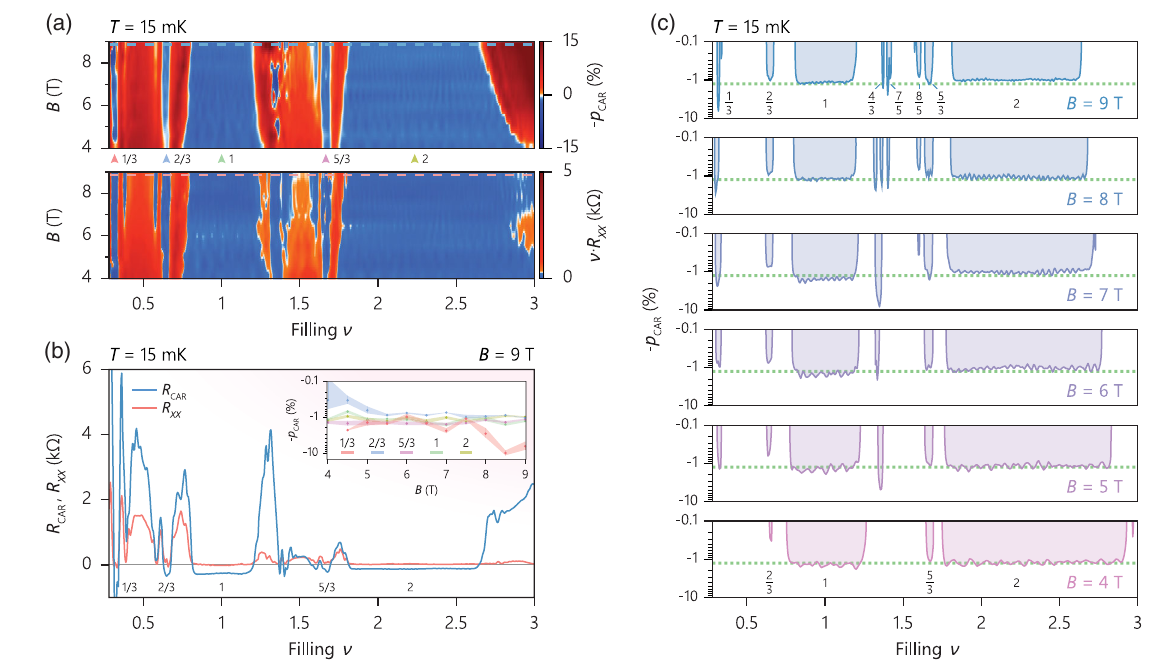
FIG. 3. Magnetic field dependence. (a) p and R (normalized for different ν ) as a function of filling and magnetic field B . These XX CAR measurements have a step size of 0.5 Tand have been interpolated in B axis corresponding to 0.1 T steps in order to provide visibility for the evolution of the conductance features in magnetic field. (b) R and R at B ¼ 9 T from (a). Small R indicates negligible bulk XX XX CAR conductance. Inset of (b) shows p from (a) as function of B for several ν . p of ν ¼ 1 = 3 shows a strong B dependence reaching CAR CAR ∼ 1 % for the rest of the fillings shown. The shades represent the uncertainty in the measured values. (c) p 10% at B ¼ 8 . 5 T. p CAR CAR from (a) for B ¼ 4 ; … ; 9 T. p at ν ¼ 1 = 3 and 4 = 3 changes with B , reaching, respectively, > 6 % ( B ¼ 9 T) and > 8 % ( B ¼ 7 T). The CAR rest of the fillings are insensitive to B once they are well developed. The dashed line is the average p for fillings which do not exhibit CAR a B